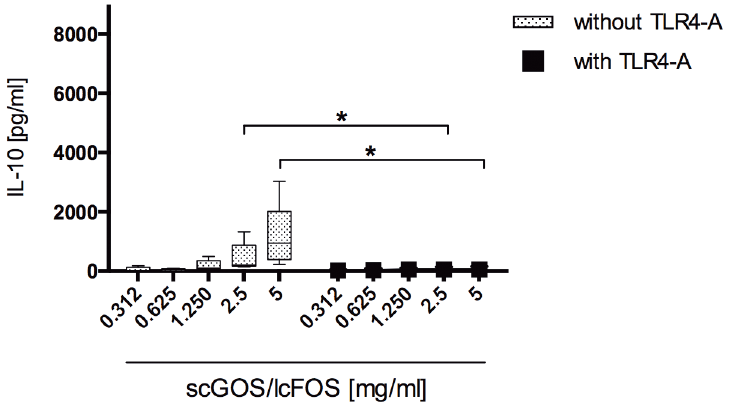
Fig 2. Stimulation with scGOS/lcFOS directly induces a dose dependent IL-10 release by MoDC that is impaired by addition of a TLR4 antagonist. Immature human MoDC were exposed to oligosaccharide mixture scGOS/lcFOS (312 μ g/ml – 5 mg/ml) for 24h in the presence (black marks) or absence (grey marks) of a TLR4 antagonist. The amount of IL-10 was measured by ELISA in cell-free supernatant. Results are presented as mean ± SEM, five independent experiments are shown. * p < 0.05, Mann Whitney test. scGOS/ lcFOS = short chain galacto-, long chain fructo-oligosaccharide-mixture, MoDC = monocyte-derived dendritic